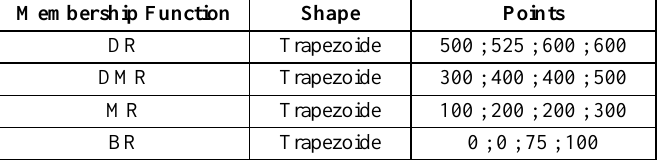
Table 4: Photo member functions r.